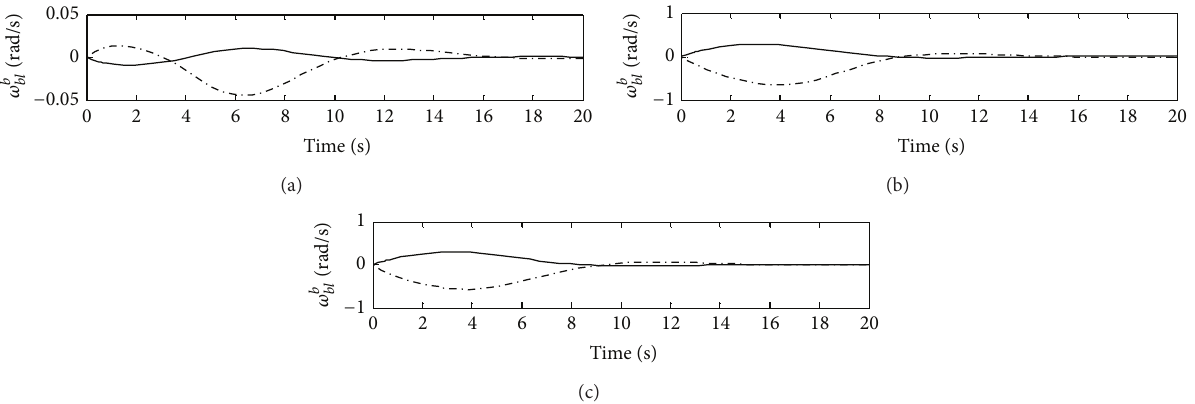
Figure 3: Angular velocity; Theorem 3 (solid line) and PD-like control law (dash-dot line).